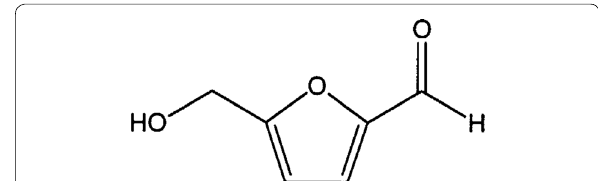
Fig. 1 Chemical structure of